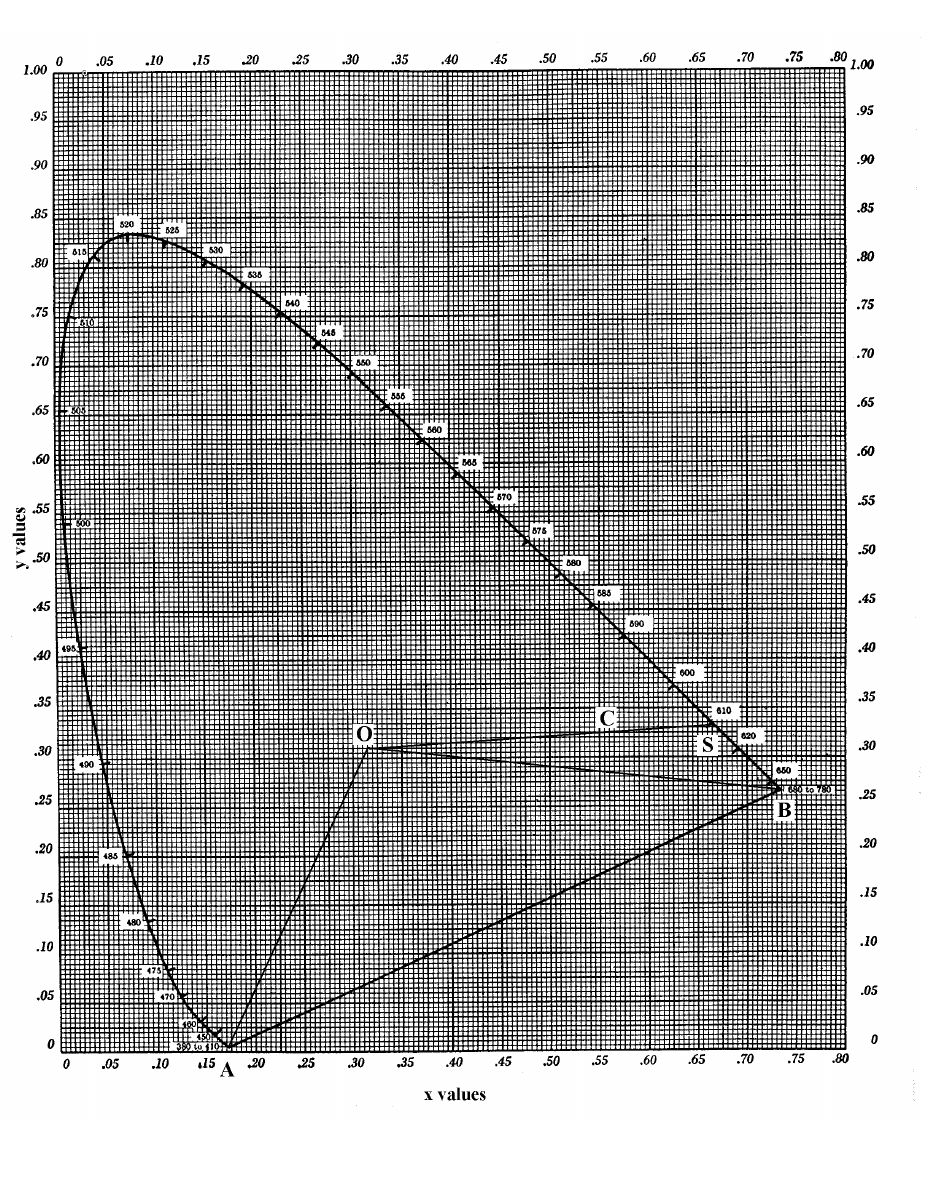
Chromaticity diagram, showing the locus of all colors of the